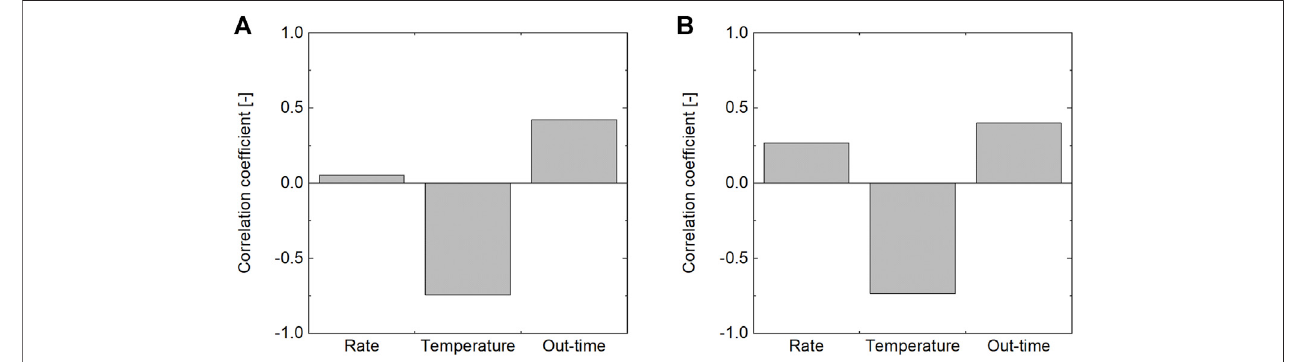
FIGURE 13 | Correlation coef fi cient of mechanical properties of uncured IM7/8552 prepreg. (A) Transverse tensile modulus. (B) In-plane shear modulus.